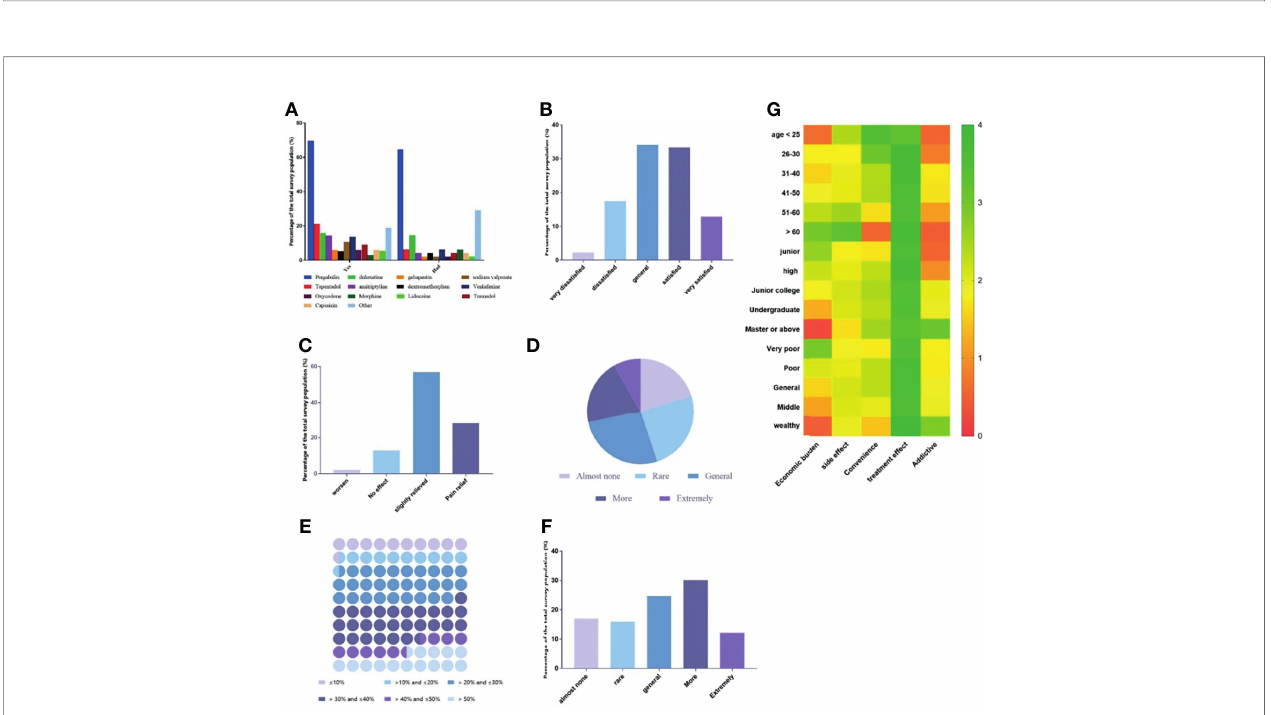
FIGURE 2 | The current status of the use of analgesics in each group of patients. (A) Currently commonly used analgesics for DPN patients; (B) Patient satisfaction with analgesics; (C) Patient ’ s self-reported pain relief after medication; (D) Patients report the economic burden of using analgesics; (E) The ratio of the cost of analgesics to the cost of diabetes treatment; (F) Patient ’ s self-reporting of the effect of analgesics on the quality of life; (G) The patient ’ s preference for the considerations of choosing analgesic